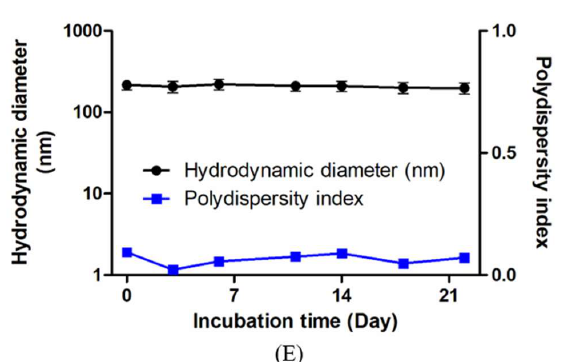
Figure 1. Characterizations of gold nanoparticles (AuNPs) and AuNP-encapsulated human serum albumin nanoparticles (Au@HSANPs). ( A ) The maximum absorption peak of AuNPs prepared by Turkevich’s method was at 525 nm; ( B ) the AuNPs exhibited a monodisperse structure and the average particle size was 22.5 ± 5.9 nm; ( C , D ) size distribution and TEM images. The hydrodynamic diameter of Au@HSANPs was 213.3 ± 32.9 nm determined by DLS; ( E ) the stability of Au@HSANPs represented by the change of particle size and PDI after incubation in deionized water at 4 °C for 22 days.